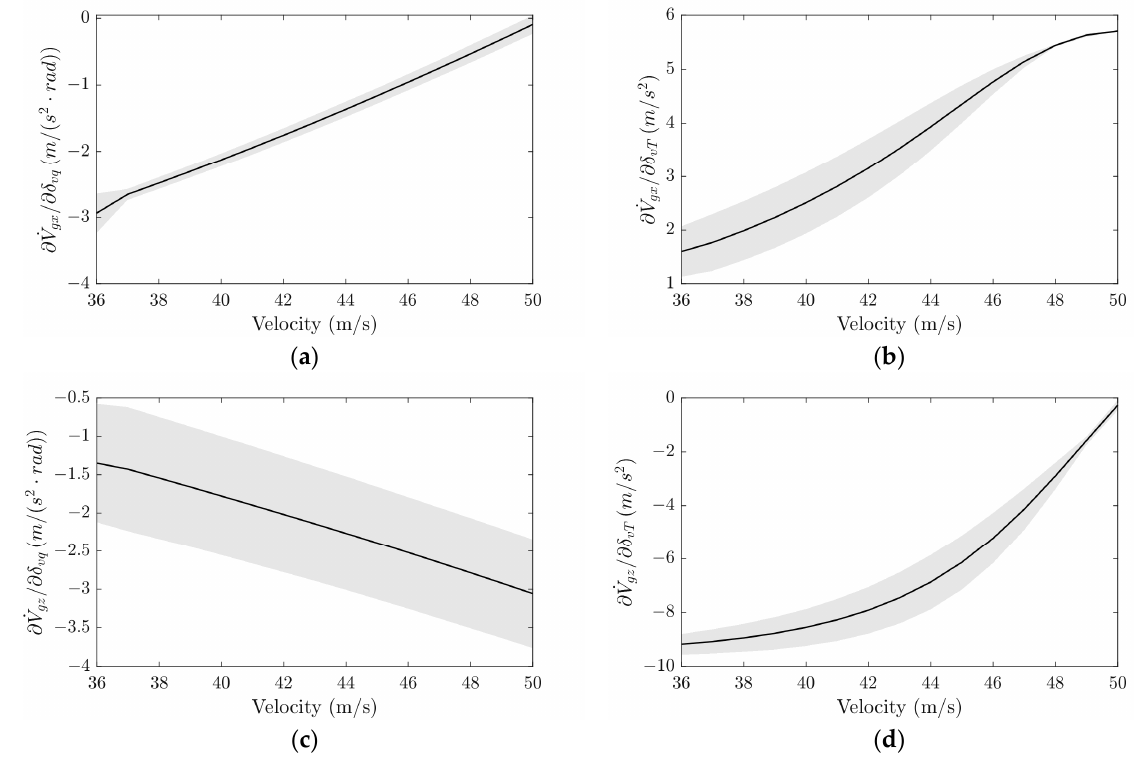
Figure 10. Control input matrix for acceleration (angle of attack α = 4 deg); the gray area is the continuous error bar for various sink rates (0~ − 4m/s): ( a ) G 11 , ( b ) G 12 , ( c ) G 21 , and ( d ) G 22 .